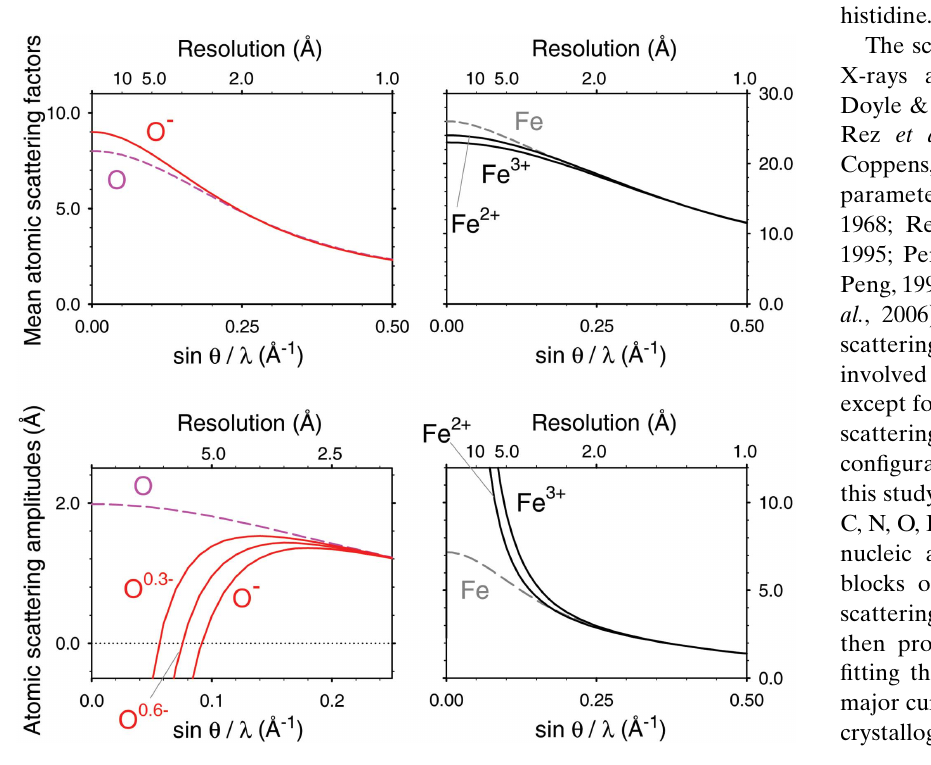
Figure 1 Plots of typical X-ray (upper row) and electron (lower row) scattering factors from the literature [ e.g. International Tables for Crystallography (Colliex et al. , 2006)]. The electron scattering factors of O and O (cid:2) are displayed up to sin (cid:2) / (cid:3) = 0.25 A˚ (cid:2) 1 and the others are up